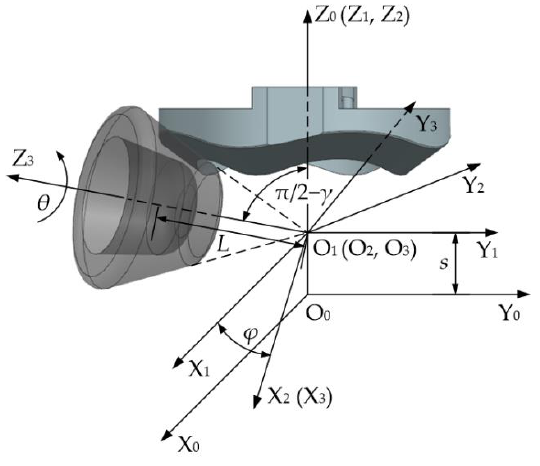
Figure 6. Reference frame.